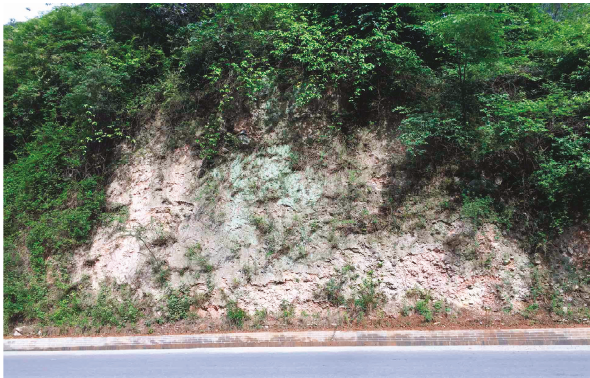
Figure 1: Landslide deposits in Lueyang County.